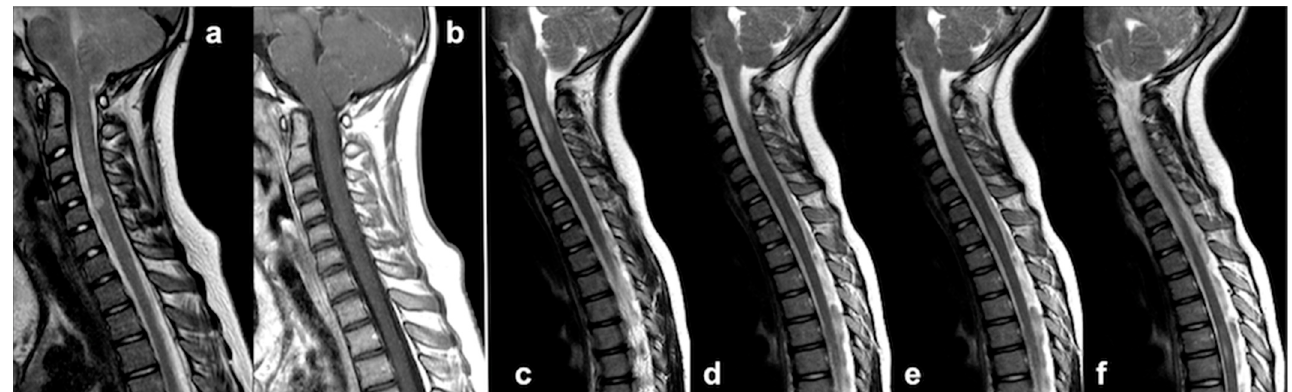
Figure 8. Single and multiple spinal unidentified bright objects (UBOs) in two different NF1 patients. Patient 1: Sagittal TSE T2w ( a ) and contrast-enhanced TSE T1w MRI ( b ) of a 11 year-old boy, showing an isolated and well-defined T2-hyperintense, T1-hypointense, unenhancing lesion localized in the ventral portion of the cervical spine (C4-C5 level). Patient 2: Sagittal TSE T2w at the three most significant levels ( c – f ) of a 4 year-old girl, showing multiple spinal lesions disseminated through cervical and thoracic spinal cord.